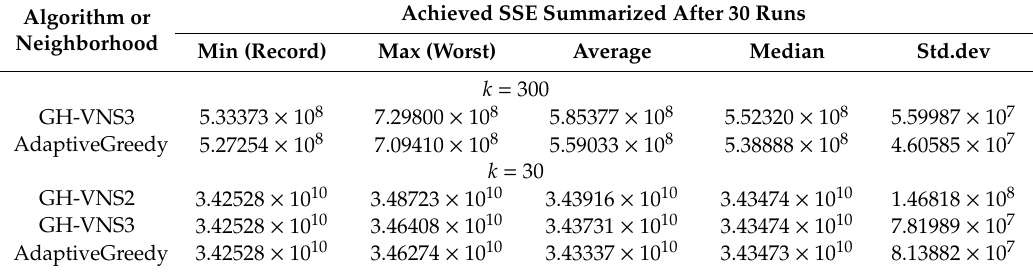
Table 2. Additional benchmarking on NVIDIA GeForce 9600GT GPU. Comparative results for